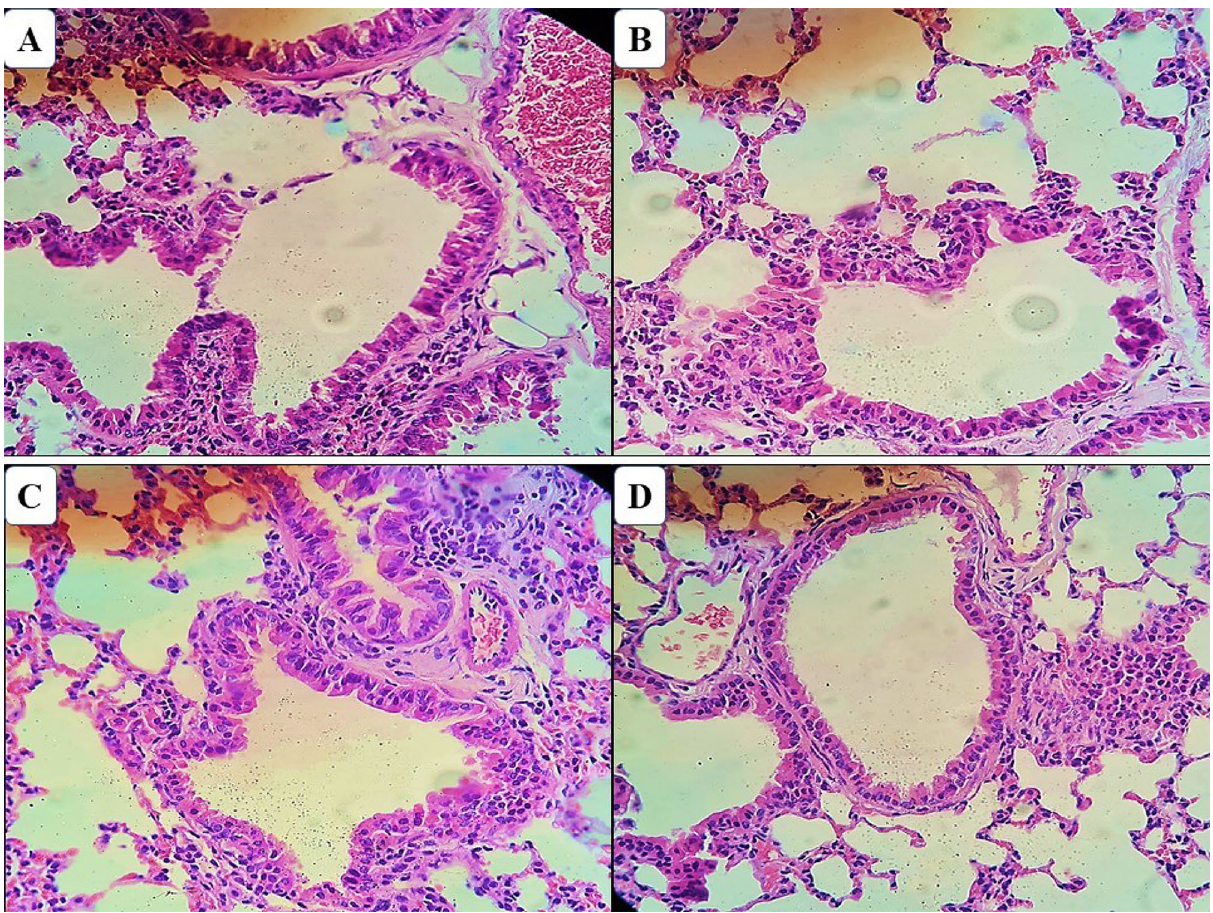
Figure 7. Photomicrograph of the lungs of mice treated with ethanol extract and alkaloid fraction of Aspidosperma nitidum . ( A ) Group treated with ethanol extract; ( B ) control group (water:DMSO); ( C ) group treated with alkaloid fraction; ( D ) control group